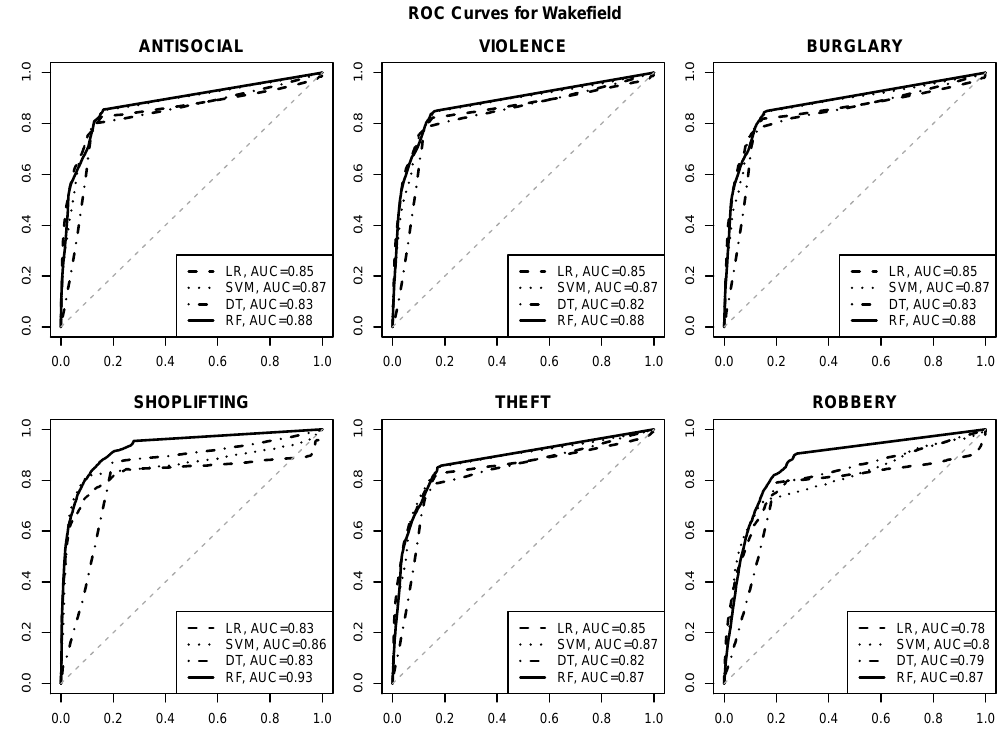
Figure 9. The ROC curves for crime risk prediction in